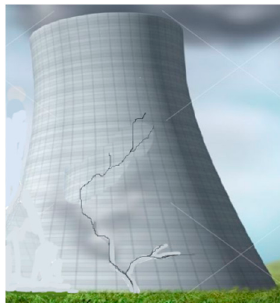
Figure 2. Nuclear power plant: reactor meltdown.